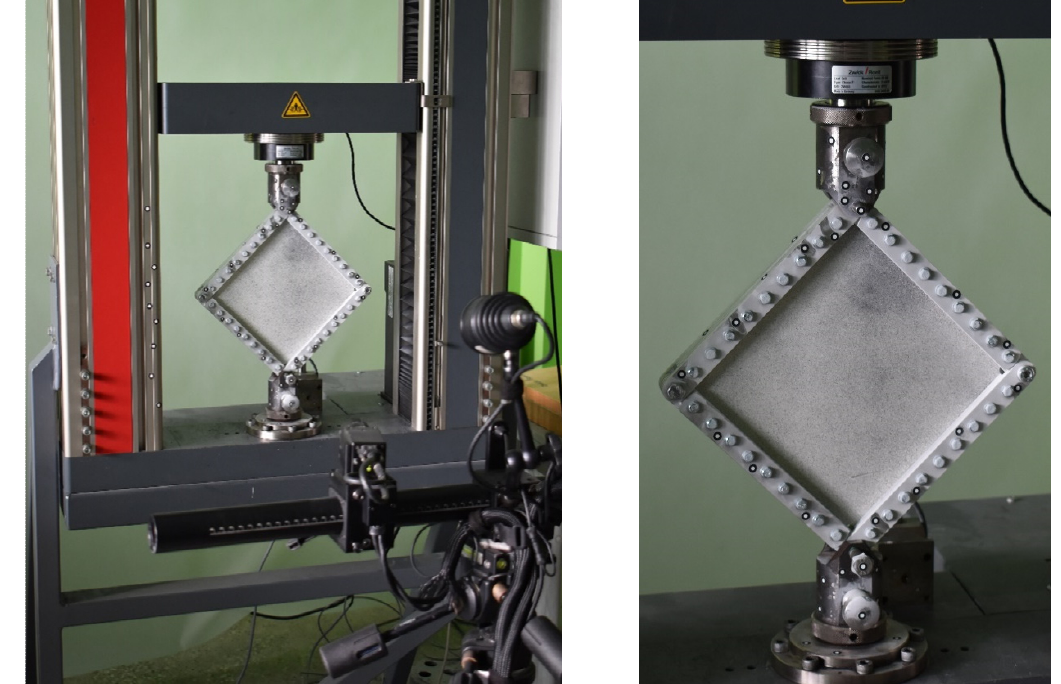
Figure 6. Shear modulus measurement stand.